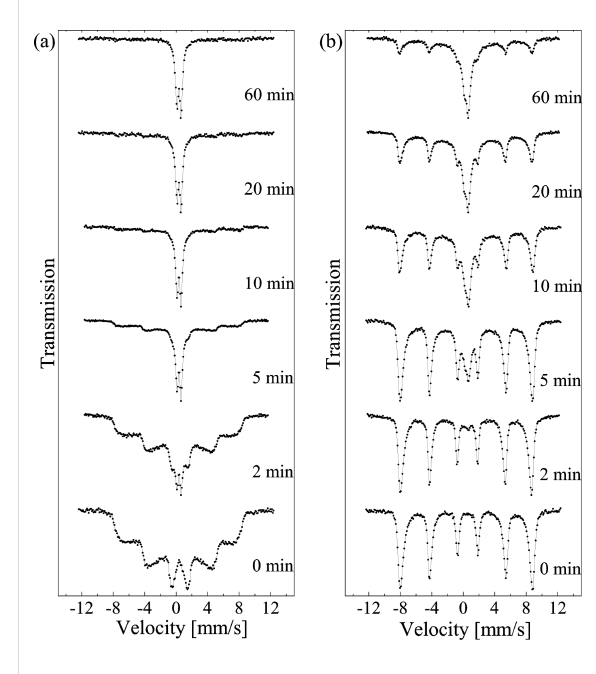
Figure 7: Mössbauer spectra of 8 nm hematite nanoparticles ground in a mortar with η -Al 2 O 3 nanoparticles for the indicated periods of time. (a) Spectra obtained at room temperature. (b) Spectra obtained at 80 K. Reprinted with permission from Xu, M.; Bahl, C. R. H.; Frandsen, C.; Mørup, S. Inter-particle interactions in agglomerates of α -Fe 2 O 3 nanoparticles: Influence of grinding, J. Colloid Interface Science 2004, 279 132–136. Copyright (2004) by